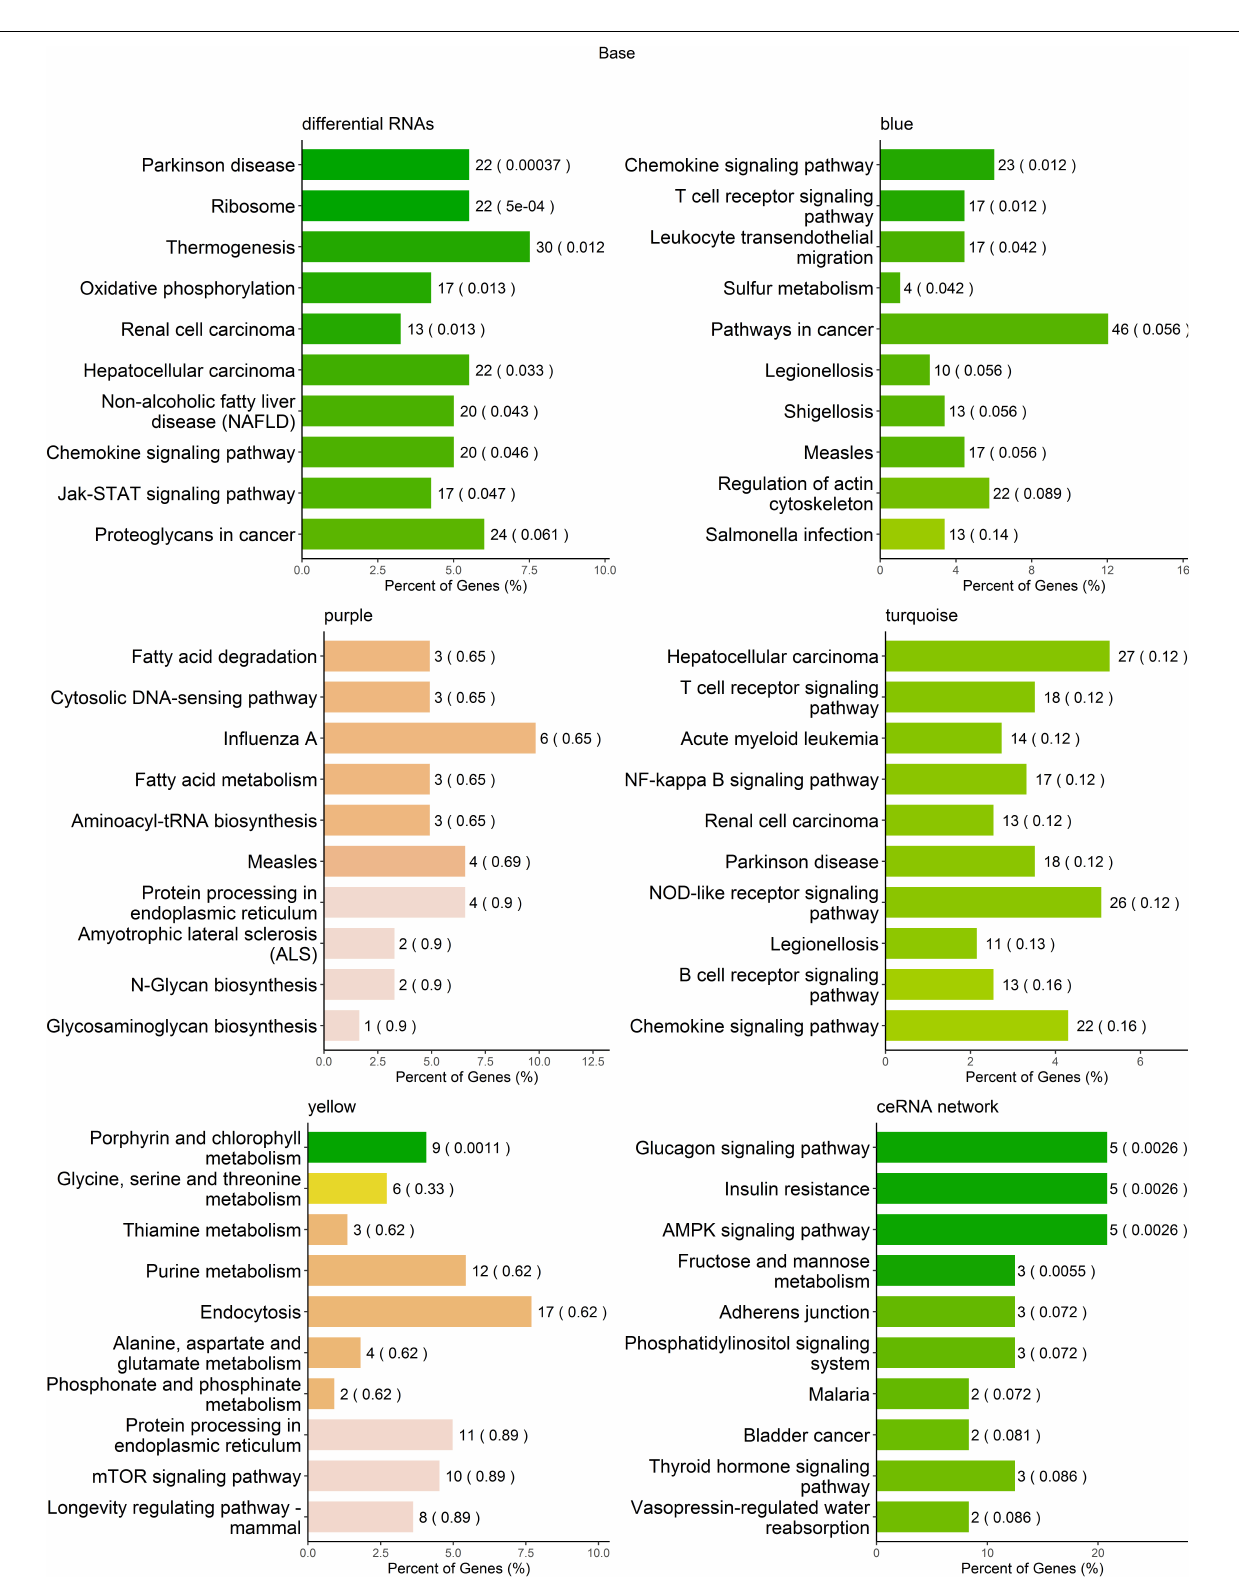
Frontiers in Psychiatry |